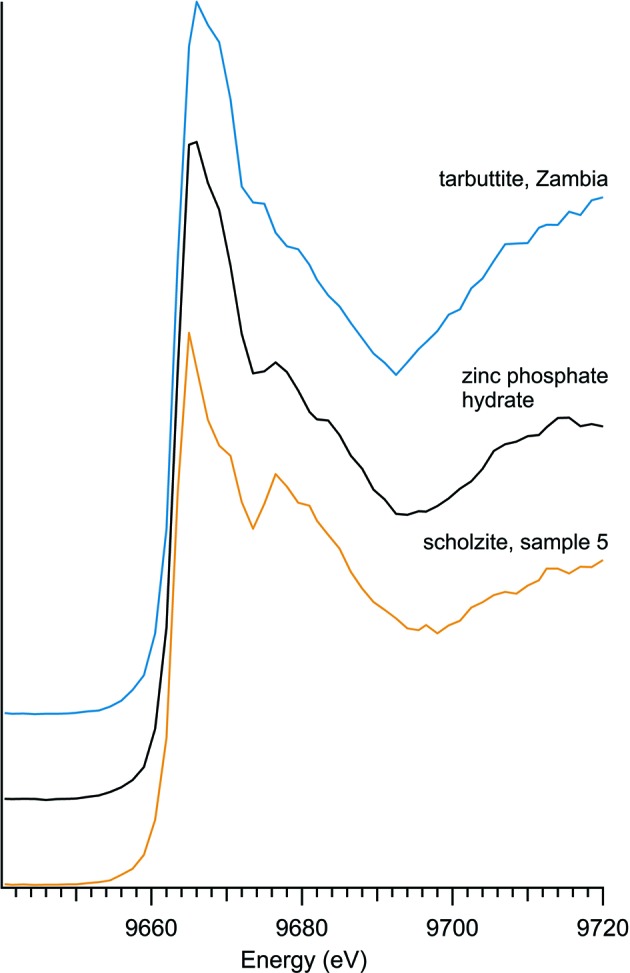
Zinc phosphate spectra.